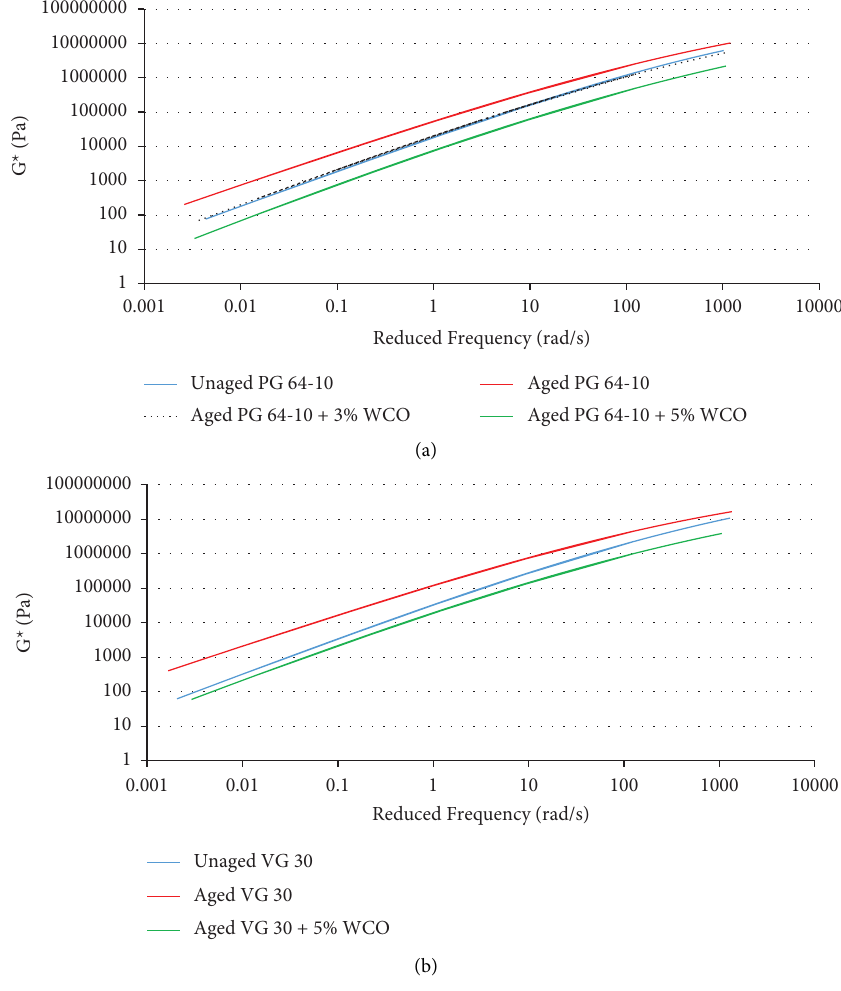
Figure 6: Master curve for bitumen binders. (a) PG 64-10; (b)